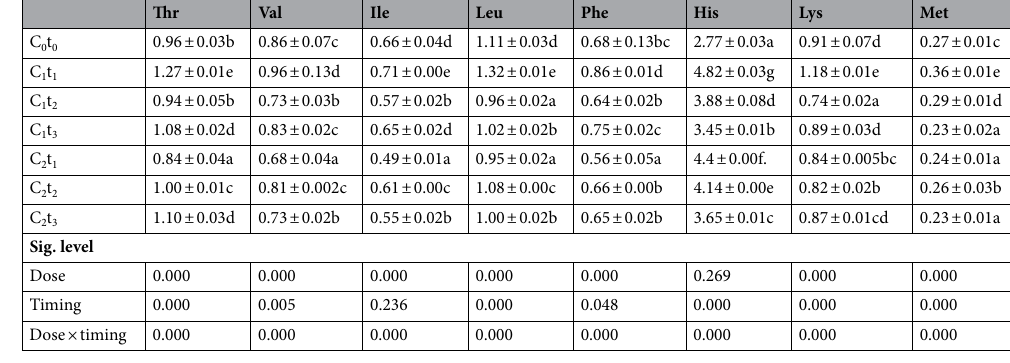
Table 5. Essential amino acids (%dw) of P. ostreatus mushrooms cultivated on supplemented substrates. C 1 3 g kg −1 , C 2 5 g kg −1 , t 1 supplementation at spawning, t 2 supplementation after the first harvest, t 3 supplementation at spawning and after the first harvest, Thr threonine, Val valine, Ile isoleucine, Leu leucine, Phe phenylalanine, His histidine, Lys lysine, Met methionine, do dose, tim timing. Values are means; means within the same column followed by the same letters are not significantly different at P < 0.05 according to Duncan’s multiple range test.